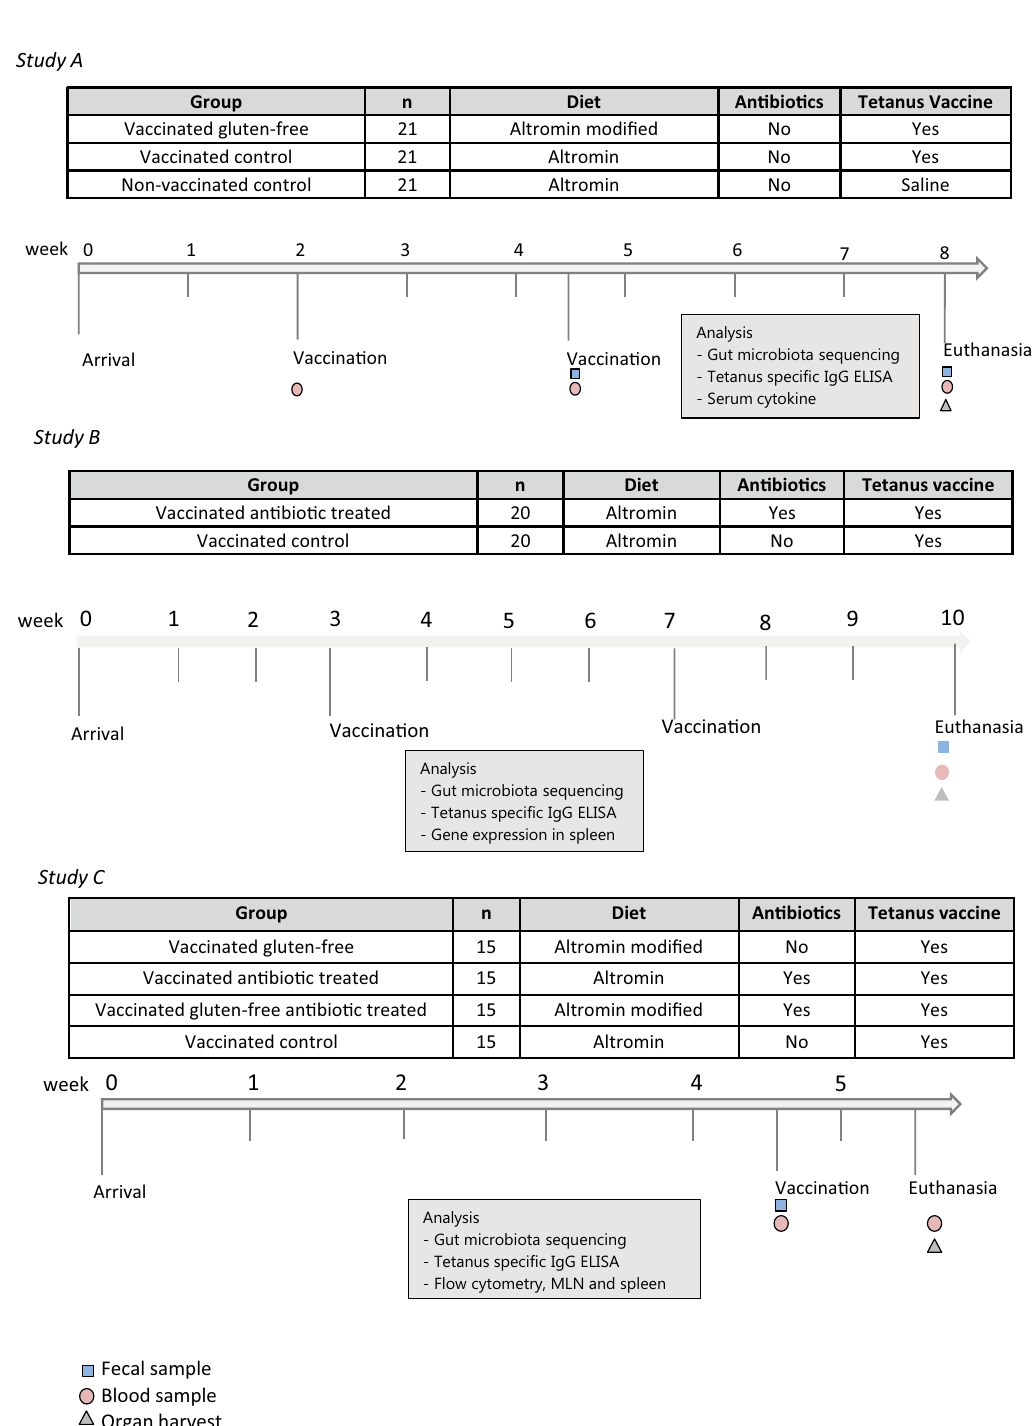
Fig 1. Overall study plan for testing vaccine impact from diet and antibiotics. We set up three studies in BALB/cBomTac mice, to investigate the influence of gut microbiota manipulations on the response to a tetanus vaccine. Two studies (A and B) to study the impact of either a gluten-free diet or antibiotics on the antibody production after a boosted vaccination regime, and one study (C) to study the immediate impact of one vaccination on immune cells counts in gluten-free fed or antibiotics treated mice. In study A we boosted with a second vaccination after two and a half weeks, while we in study B considered that his might be too short and did the boosting after four weeks. In study C we used only one vaccination, because the aim was to see the cell counts in relation to our observations after the first vaccination in study A and B, and, therefore, we also sampled the animals only one week later. Two